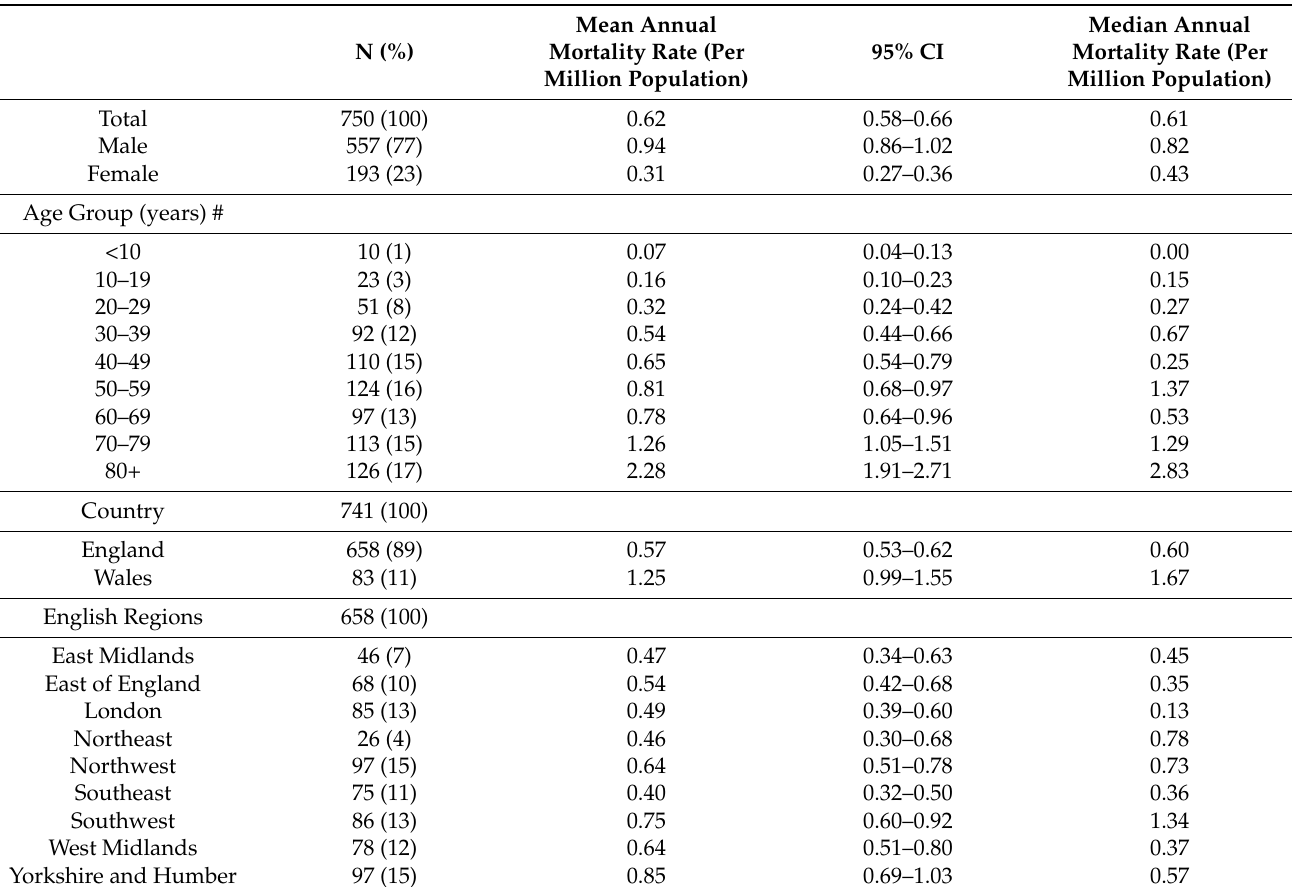
Table 2. The descriptive characteristics of deaths from UNFR CO poisoning in England and Wales,